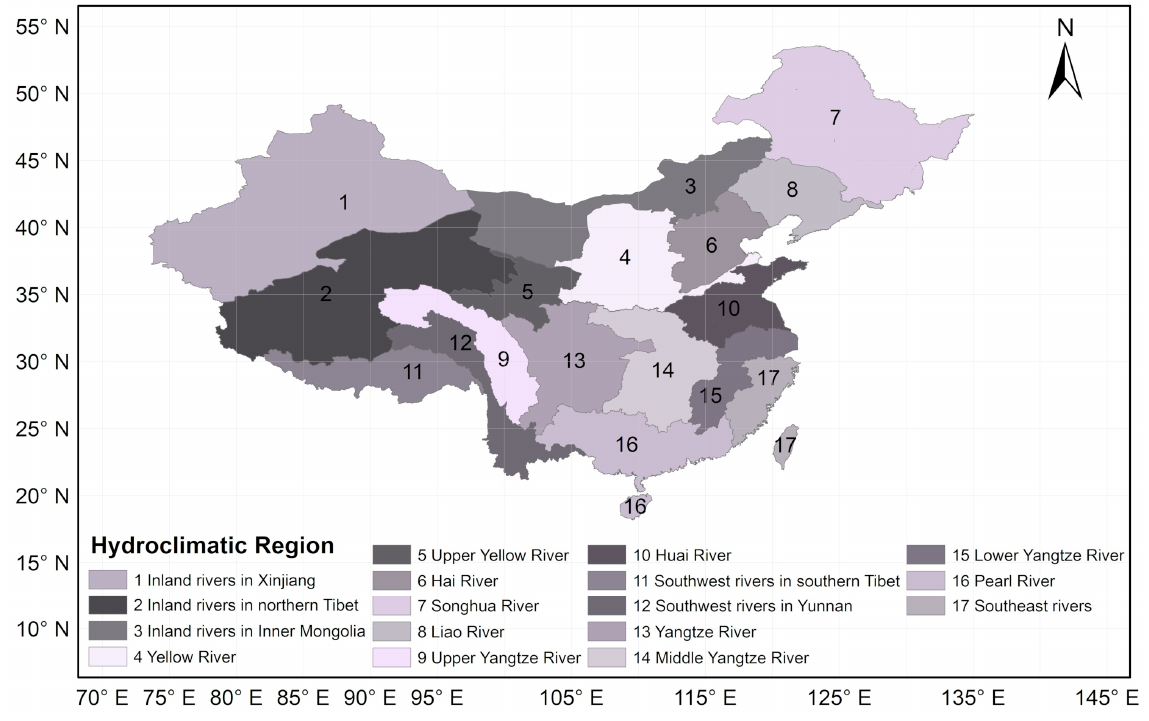
Figure 1. Hydroclimatic regions over China.